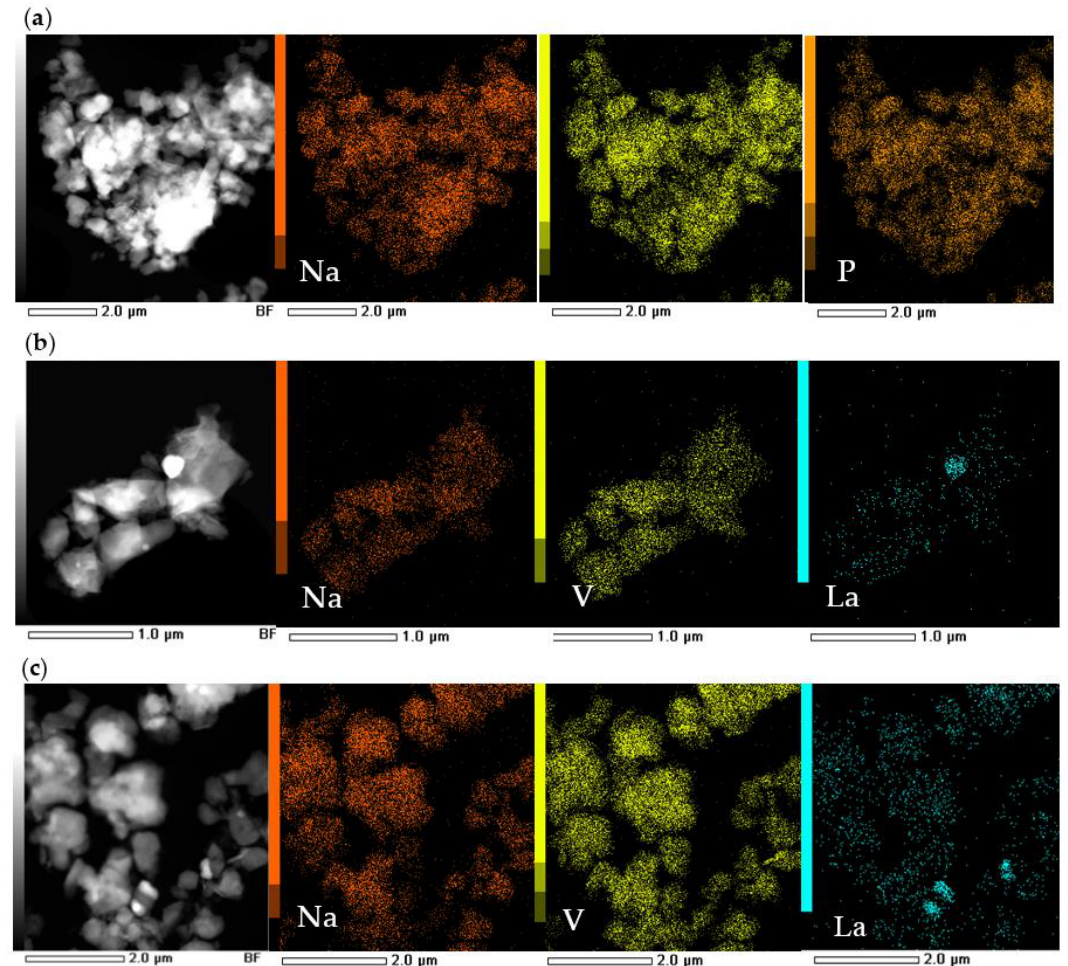
Figure 3. STEM/EDS element mapping images of NVPF ( a ); NVPF-La05 ( b ); and NVPF/LPO ( c ).